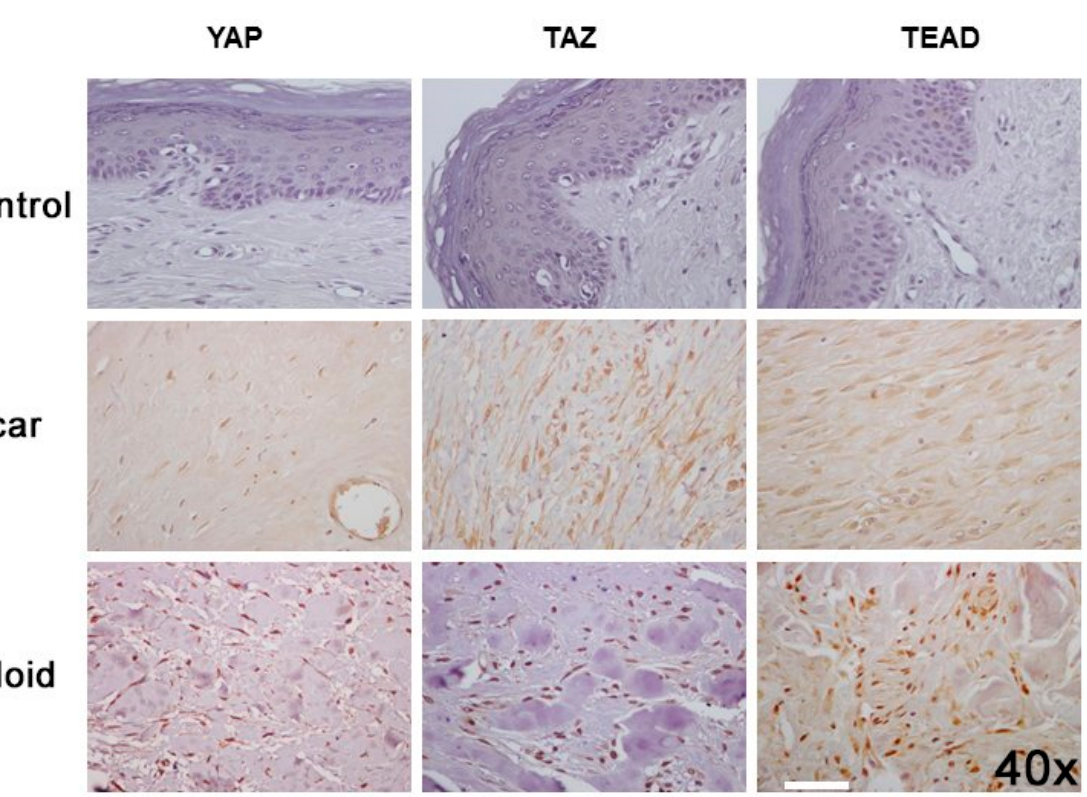
Figure 1. Hippo pathway effectors YAP, TAZ and TEAD4 are overexpressed in hypertrophic scars and keloids. Representative cases of control skin ( upper panel ), hypertrophic scars ( middle panel ) and keloids ( lower panel ) showed stronger immunopositivity in fibroblasts for YAP, TAZ and TEAD4 in keloids compared to scars (magnification 40×). Scale bar set at 20 μ m (ImageJfiji software).